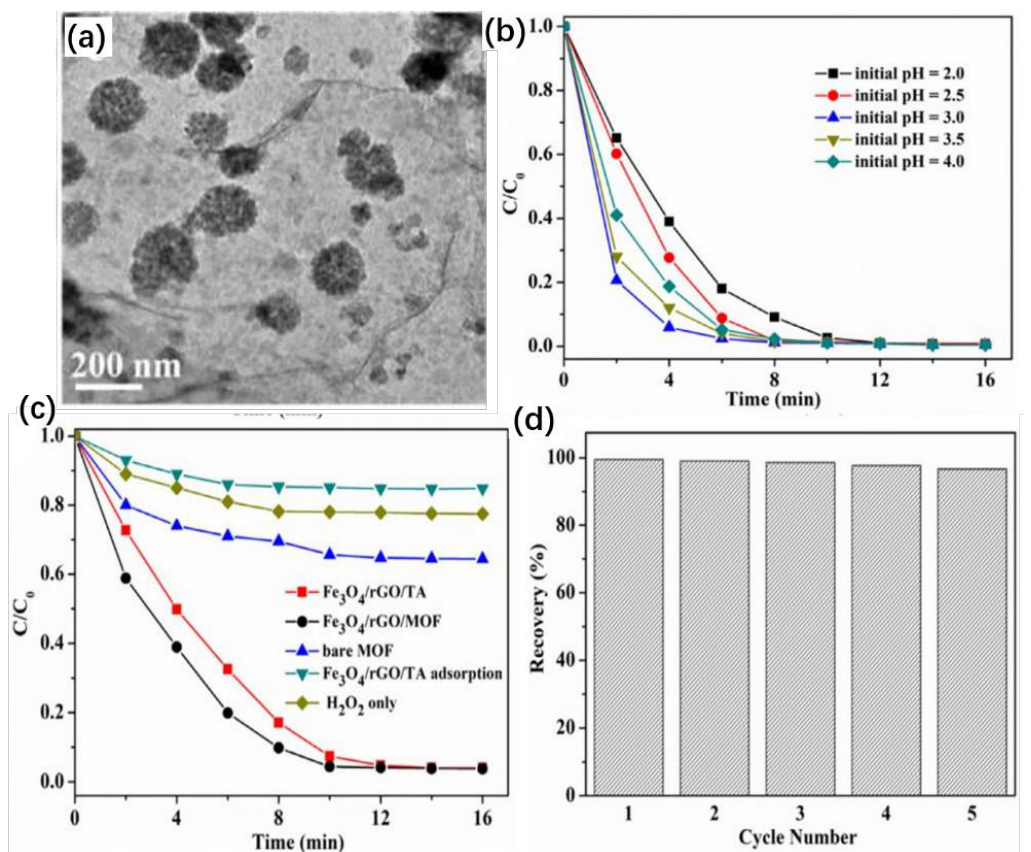
Figure 6. ( a ) TEM image of the as-prepared Fe 3 O 4 /reduced graphene oxide (rGO)/metal–organic framework (MOF). ( b ) Effect of initial pH on degradation of phenol. ( c ) Effect of catalyst dose on the degradation of phenol. ( d ) Reusability of Fe 3 O 4 /rGO/MOF. Copyright © 2019 Taiwan Institute of Chemical Engineers.